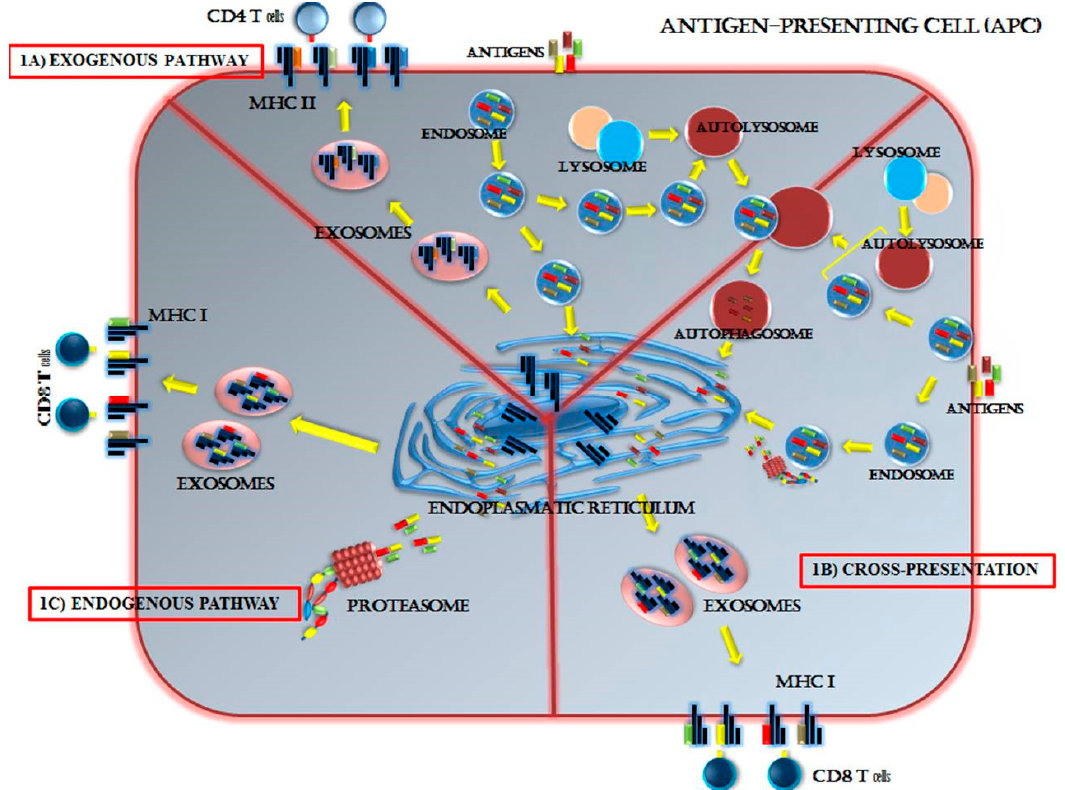
Figure 1. The role of autophagy in the presentation of immunogenic peptides in antigen-presenting cells (APCs). Autophagy has a vital role in the degradation of proteins in order for APCs to use them as antigenic peptides on Major Histocompatibility Complex (MHC)-I and II. Three distinct pathways of antigen processing by the APC have been identified: Exogenous (1A), cross-presentation (1B), and endogenous (1C) pathway. In the exogenous pathway, di ff erent antigens and peptides are produced outside the APC and placed on the MHC class II for recognition by CD4 + T cells. The exogenous pathway occurs in macrophages, dendritic cells, and B cells. The endogenous pathway loads cell-produced antigenic peptides onto MHC class I for recognition by CD8+ T cells. The endogenous pathway is responsible for immune recognition of peptides from the virus or self-digested peptides. The endogenous pathway characterizes many cell types, not just APCs, allowing for sensing of viral infection in all cell types. In the cross-presentation pathway, different peptides, from endocytosis and the autophagy degradation pathway, are loaded on MHC class I for recognition by CD8+ T cells. The peptides originate from the surrounding cell environment of tumor apoptotic bodies. This pathway targets virus-infected cells other than APCs and the tumor. The cross-presentation pathway is identified as the most efficient in dendritic cells.